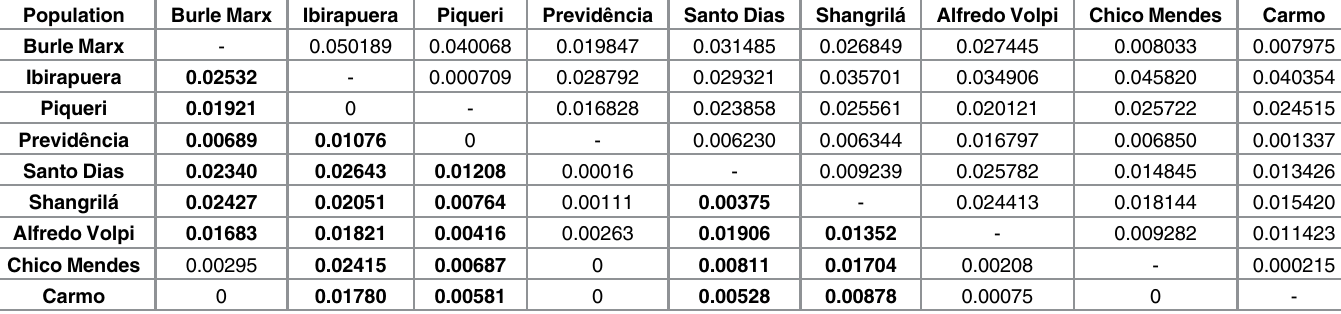
Table 2. Pairwise F ST * estimates for Aedes fluviatilis populations.